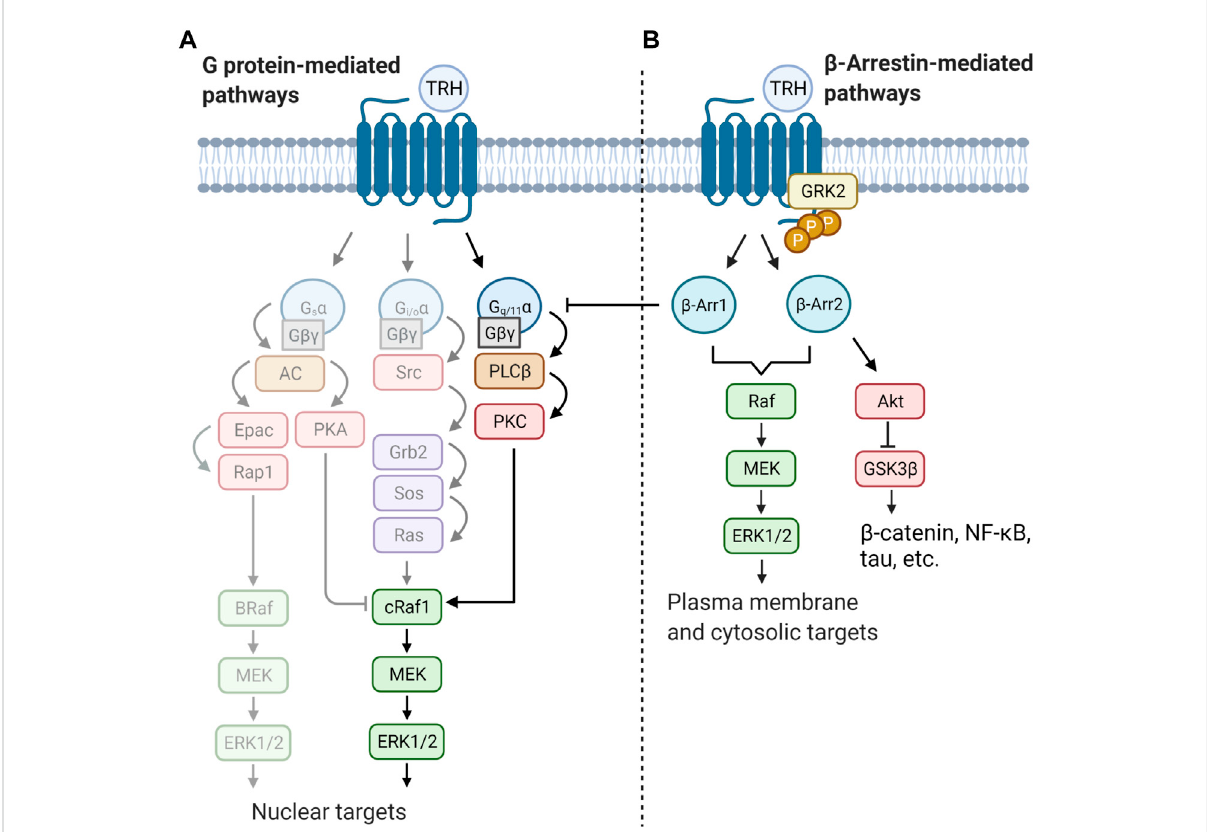
FIGURE 4 Schematic illustration of two distinct modes of regulation of MAPK cascades triggered by TRH receptor. Activity of ERK is controlled by both G protein and/or β -arrestin-mediated pathways. Activation of receptor molecule by an agonist can lead to different signalling outputs depending on the cell type and signalling molecule supply. Basically, (A) TRH signals through the canonical G q/11 α – PLC β – PKC pathway which can directly activate the fi rst protein kinase from the MAPK cascade (cRaf1). Activated ERK then translocate to the cell nucleus. TRH may possibly activate other G proteins (lighter part) and further regulates gene transcription or cell cycle progression by phosphorylation of transcription factors. (B) β -Arrestin ( β - Arr1and β -Arr2)terminatesGproteinsignalingbydesensitizationofTRH-R.Simultaneouslyitcanfunctionasscaffoldactivating anotherpoolofERK kinase which, afterwards, phosphorylates different substrates. The fi gure was created by BioRender.